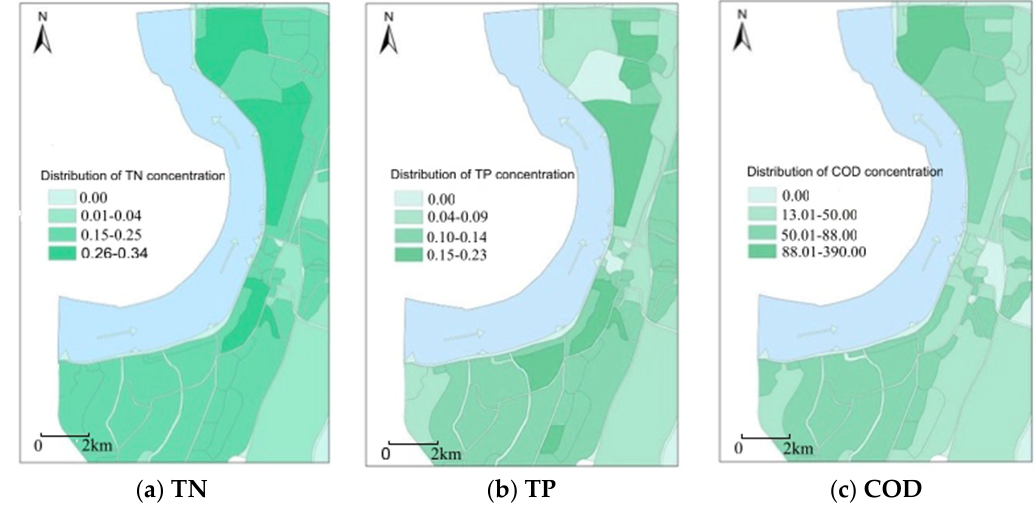
Figure 7. Relationship of pollutant emission distribution, pollutant emission level, and functional division and ( a ) TN, ( b ) TP, and ( c ) COD concentration in each division.